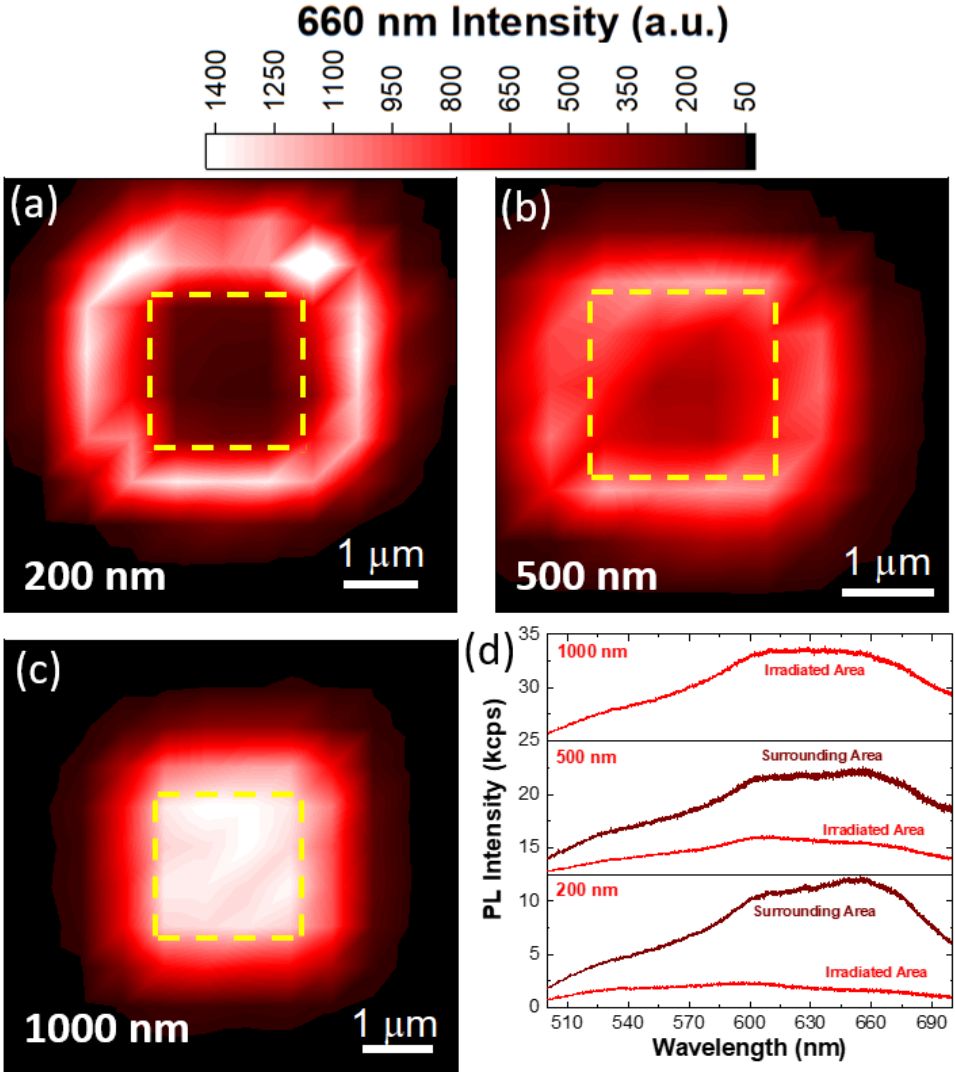
Figure 3. PL intensity map obtained at 660 nm for patterns with 200 nm ( a ), 500 nm ( b ) and 1000 nm ( c ) spacings. The upper color bar applies for all the maps. The dashed yellow square indicates the primary irradiated areas. ( d ) PL spectra of the 10 keV electron-irradiated hBN with different pattern spacings.